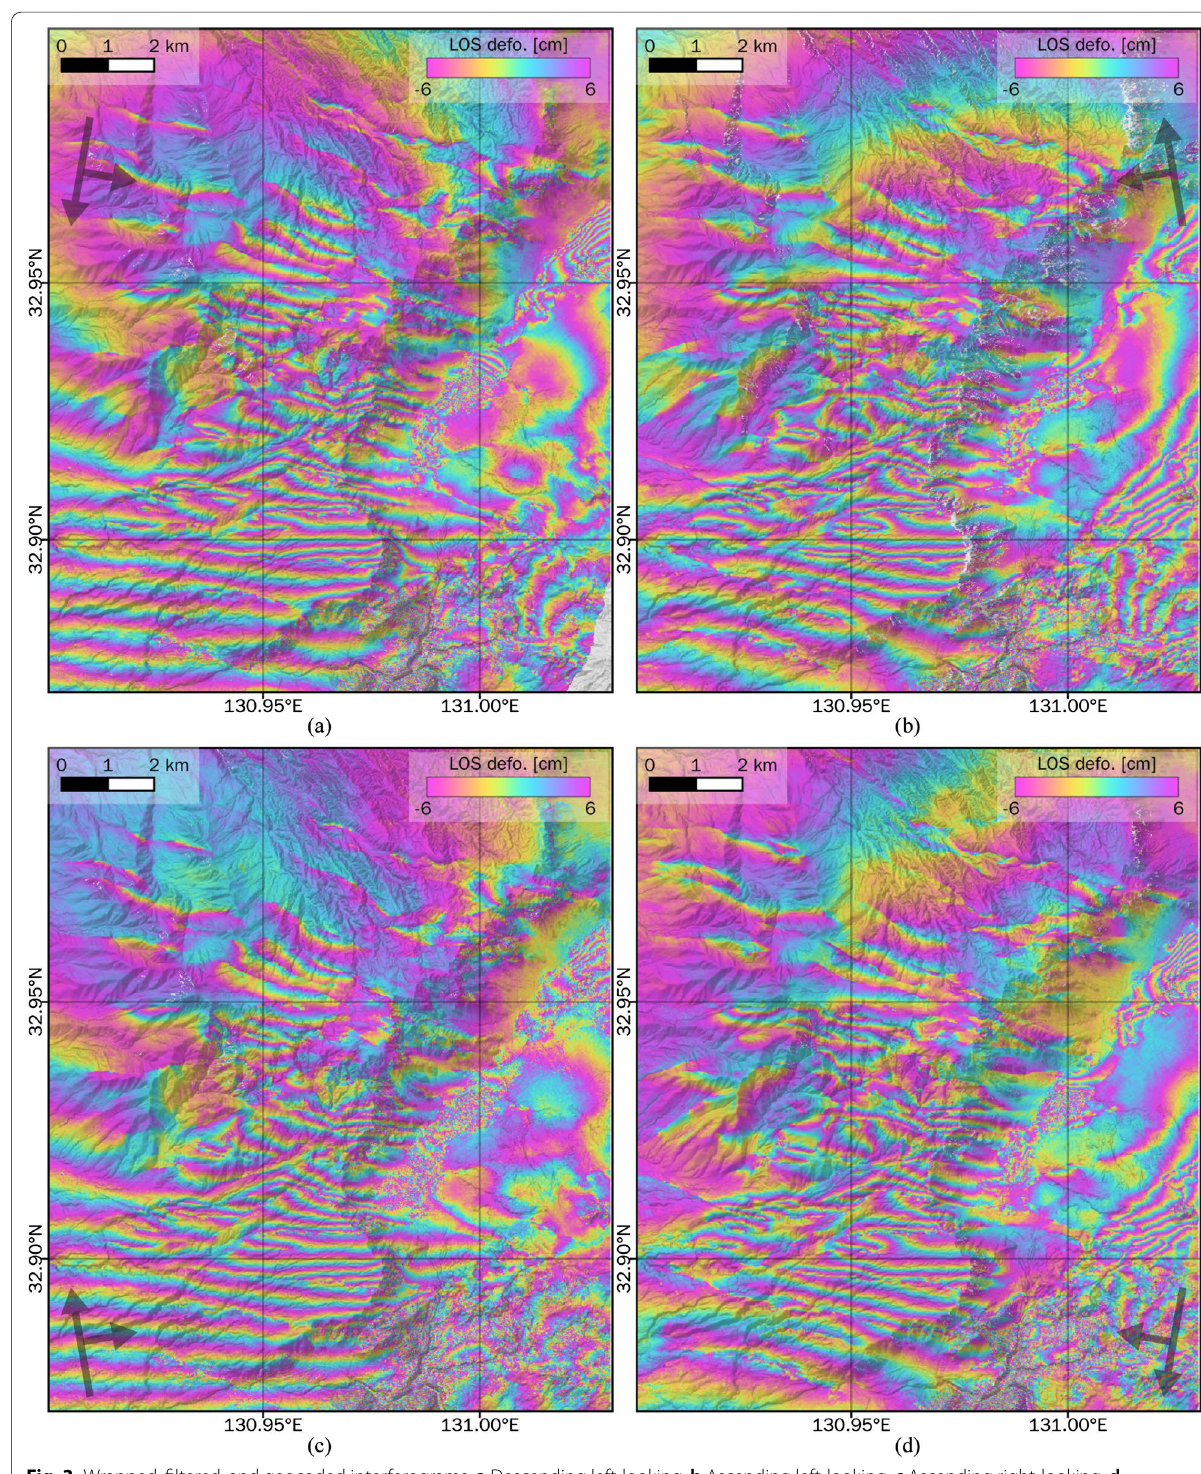
Fig. 3 Wrapped, filtered, and geocoded interferograms. a Descending left-looking. b Ascending left-looking. c Ascending right-looking. d Descending right-looking. For more detailed information on each interferogram, see Table